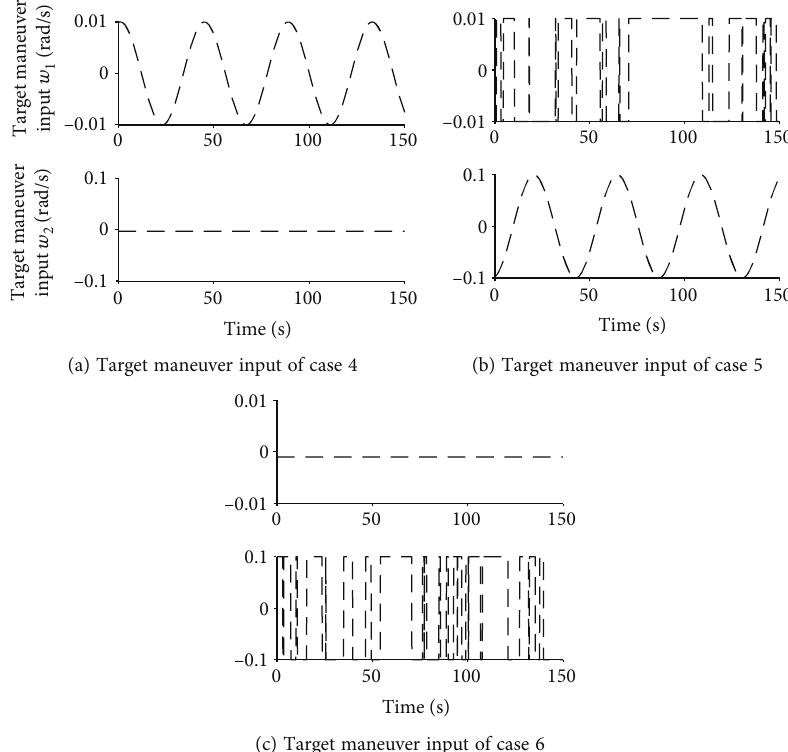
Figure 18: Target maneuver inputs in case 4, case 5, and case